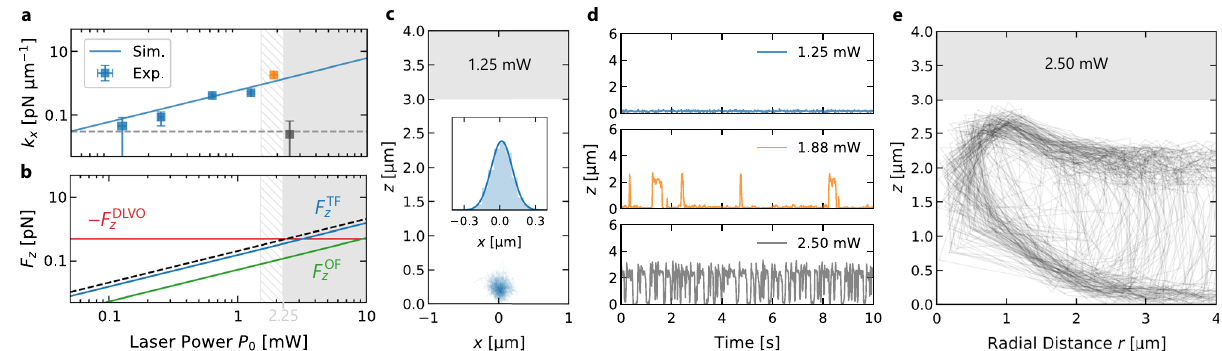
Fig. 4 Forces on trapped NPs in 10 mM NaCl. a The lateral trap stiffness k x obtained from the variance σ 2 x of the experimental lateral position histograms as function of the laser power P 0 (blue data points, k x ¼ k B T = σ 2 x , see the inset in c for the lateral position histogram at P 0 = 1.25 mW). The blue solid line represents the simulation result obtained from the lateral velocity fi eld in Fig. 3h (see Supplementary Note 9 for details). Within the dashed area the particle intermittently escapes the trapping potential in vertical direction and transitions into a regime of instant vertical repulsion for higher laser powers (shaded area). The error bars have been estimated from uncertainties of the power measurement and errors from the histogram fi tting. b The z -component of the thermo-osmotic drag force F TF z (blue line), the optical force F OF z (green line) and the total force F OF z þ F TF z (black dashed line) as function the incident laser power P 0 for a NP located at x = 0, d = 30 ( z = d + R ). The attractive DLVO force F DLVO z is independent of the incident laser power and depicted as horizontal, red line. c Trajectory of a AuNP for a heating laser power of 1.25 mW (see Supplementary Video 2 for details). The inset shows the corresponding lateral distribution histogram. d Time traces of the z -position for three different laser powers. e Trajectory of a AuNP for a heating laser power of 2.5 mW, which is above the threshold power of 2.25 mW.